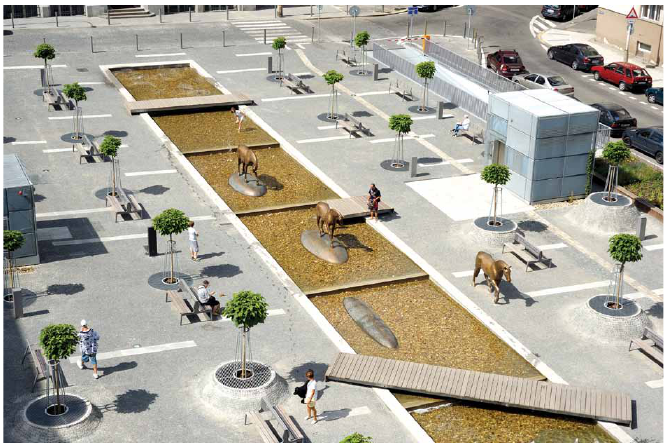
fig. 6. Pata & frydecký architekti: new square in Prague – Dejvice,